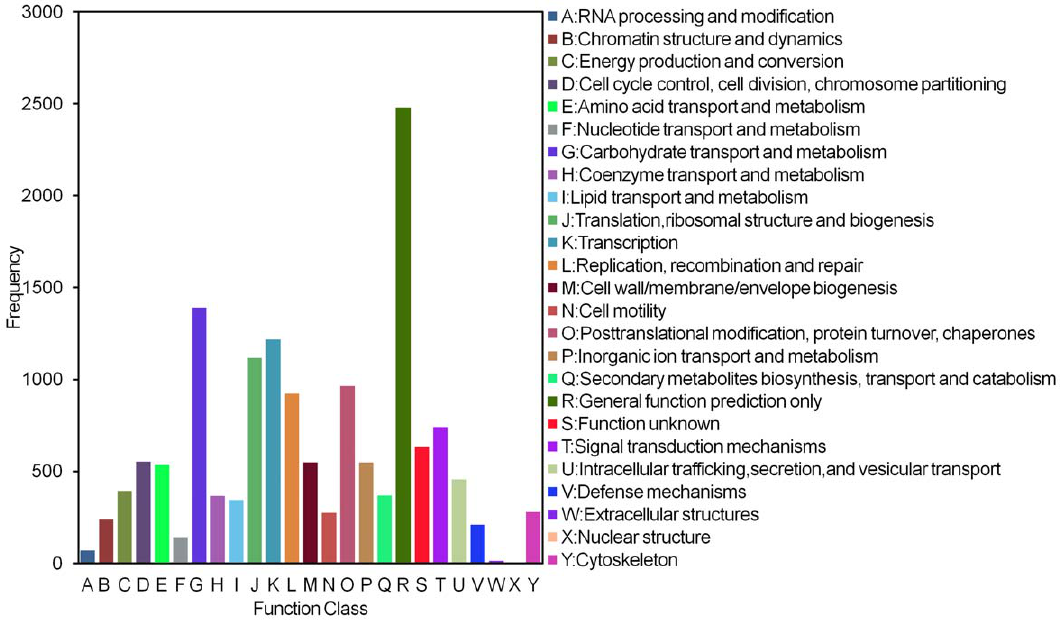
Figure 3. Histogram representation of clusters of orthologous groups (COG) classification. 7,075unigenes were assigned to 25 categories in the COG classification. The y -axis ‘Frequency’ indicates the number of genes in a specific function cluster. The right legend shows a description of the 25 function categories.